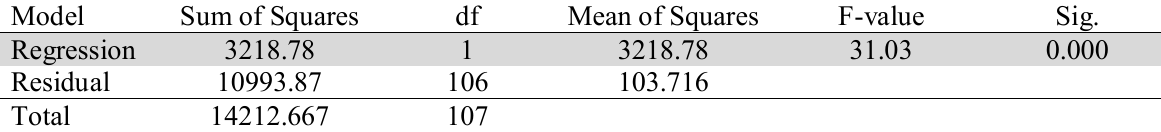
The results of stepwise regression technique Model